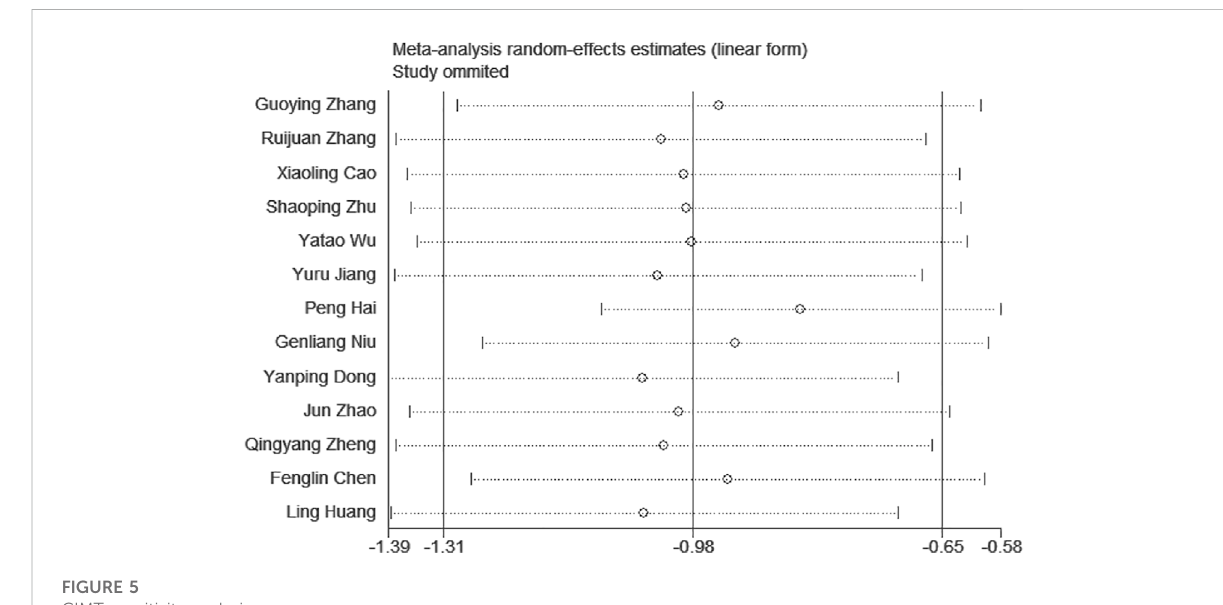
FIGURE 5 CIMT sensitivity